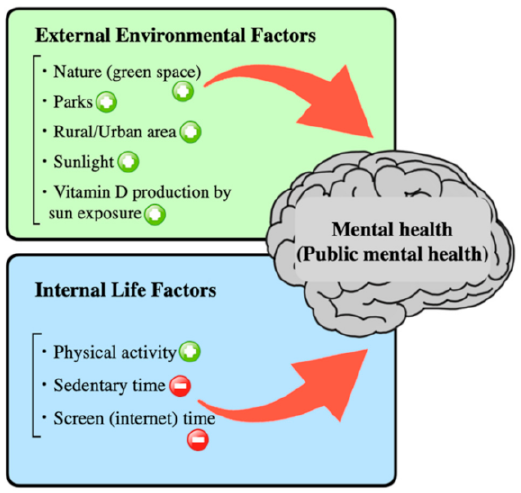
Figure 2. Graphical summary of this review: those that show a positive impact on mental health are marked with a symbol of +, while those that have a negative impact are marked with a symbol of −